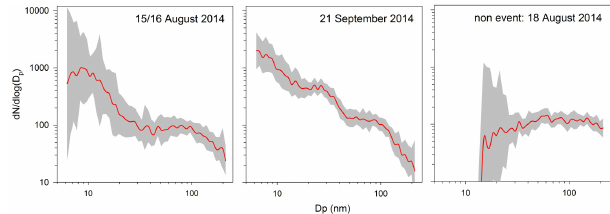
Figure 4. Mean size distribution (red line) and range of geometric standard deviation (grey envelope) during both winter particle nu- cleation events (15/16 August and 21 September 2014), as well as for a typical winter day without nucleation (18 August